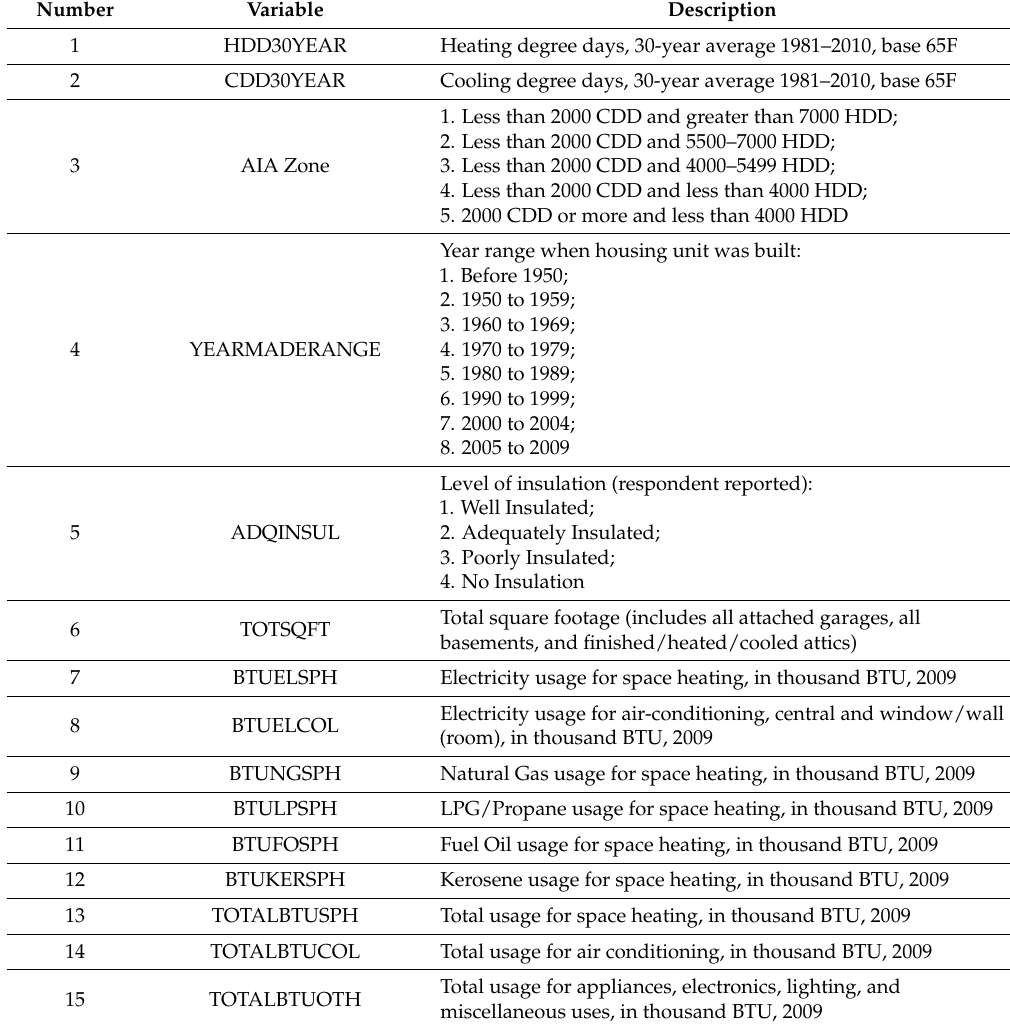
Table A2. Description of variables selected from Energy Information Agency Microdata Code